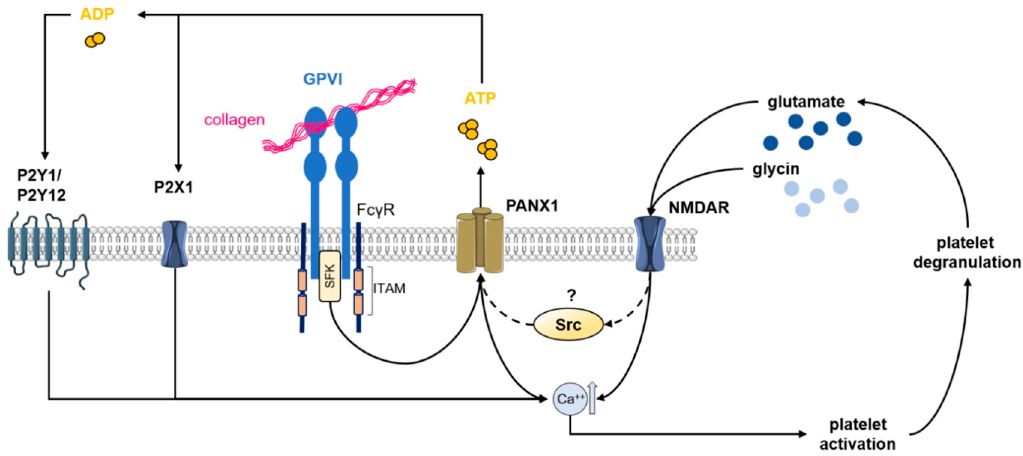
Figure 4. PANX1 and NMDAR activation upon platelet activation and signaling. Collagen binding induces activation of Src-family kinases (SFKs) which in turn activates PANX1 channels. Activation of PANX1 leads to an exchange of calcium and ATP, both modulating platelet activation through intra-and extracellular pathways. ATP directly binds to P2X1 or is degraded to ADP and binds to the purineric receptors P2Y1 / P2Y12, all inducing platelet activation. Additionally, NMDAR might influence PANX1 activation through Src kinases, but this remains unclear in platelets to date. Besides, NMDAR activation induces calcium mobilization resulting in platelet activation. In a feedback loop, activated platelets release glutamate, an essential ligand for NMDAR activation. This figure was created using images from Servier Medical Art Commons Attribution 3.0 Unported License. (http: //